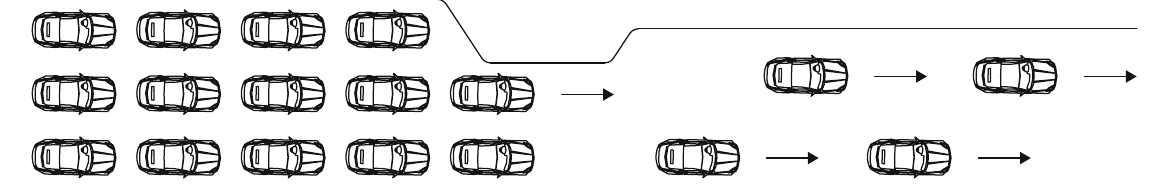
Figure 1: Sketch of a bottleneck on a commuters ’ route during rush hour tra ffi c causing the formation of a